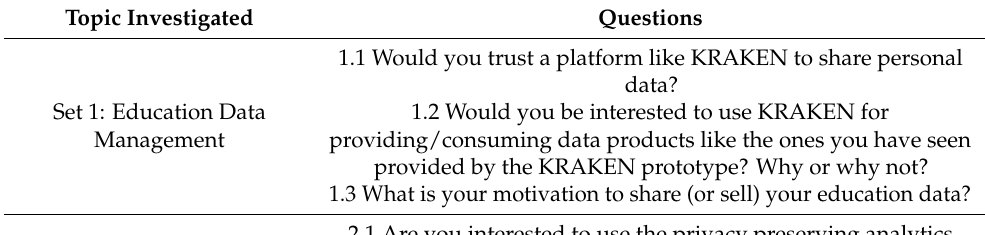
Table 2. Questions posed to participants attending the education pilot